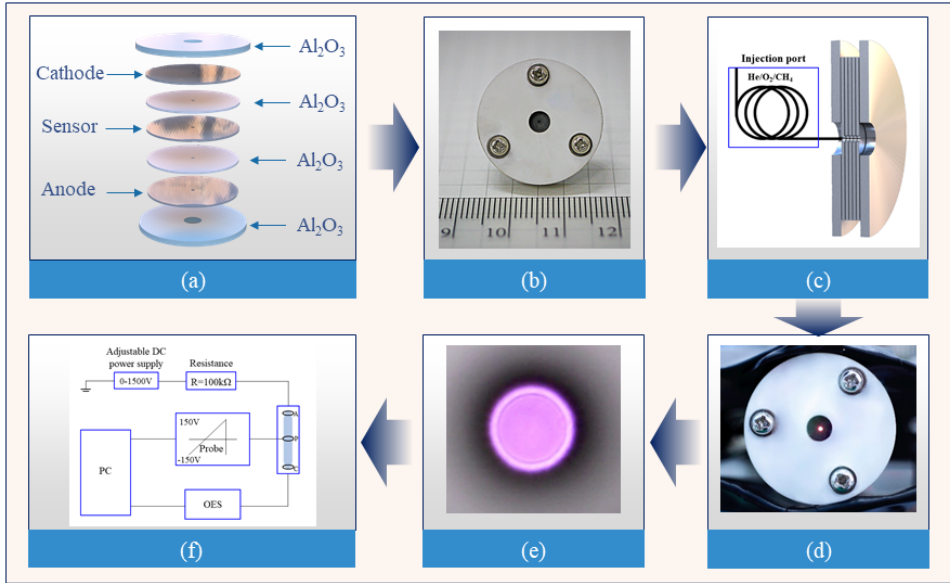
Figure 1. Sandwich-like construction: ( a ) schematic; ( b ) photograph; ( c ) schematic of the profile; ( d ) discharge photograph; and ( e ) photograph of the plasma. ( f ) Block diagram of the experimental setup.